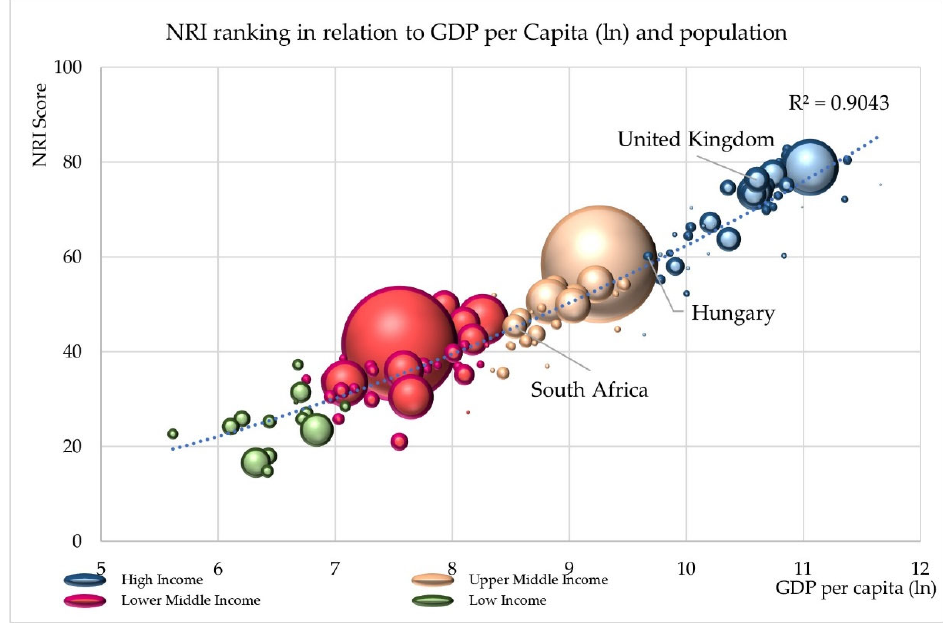
Figure 6. The three participating countries position by NRI based on GDP per capita (Source: devel ‐ oped from data from [12]). developed from data from